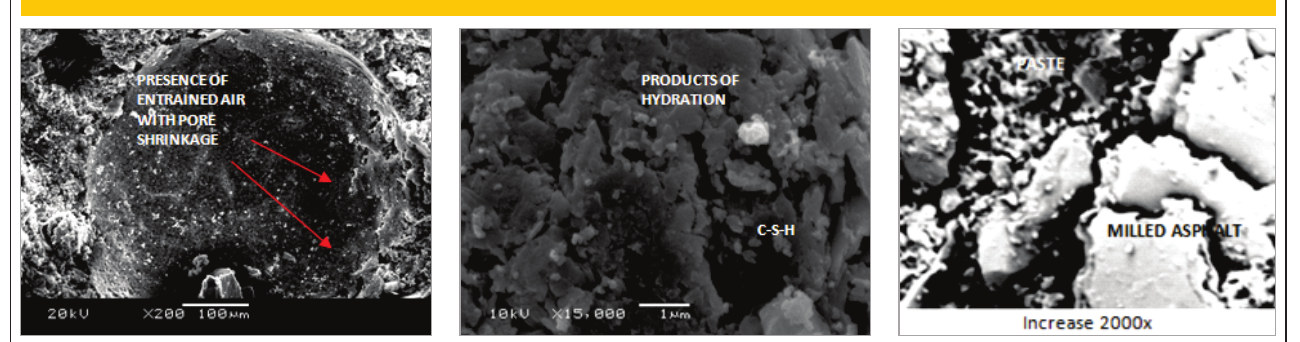
Figure 10 – Observations with MEV SE of mixture